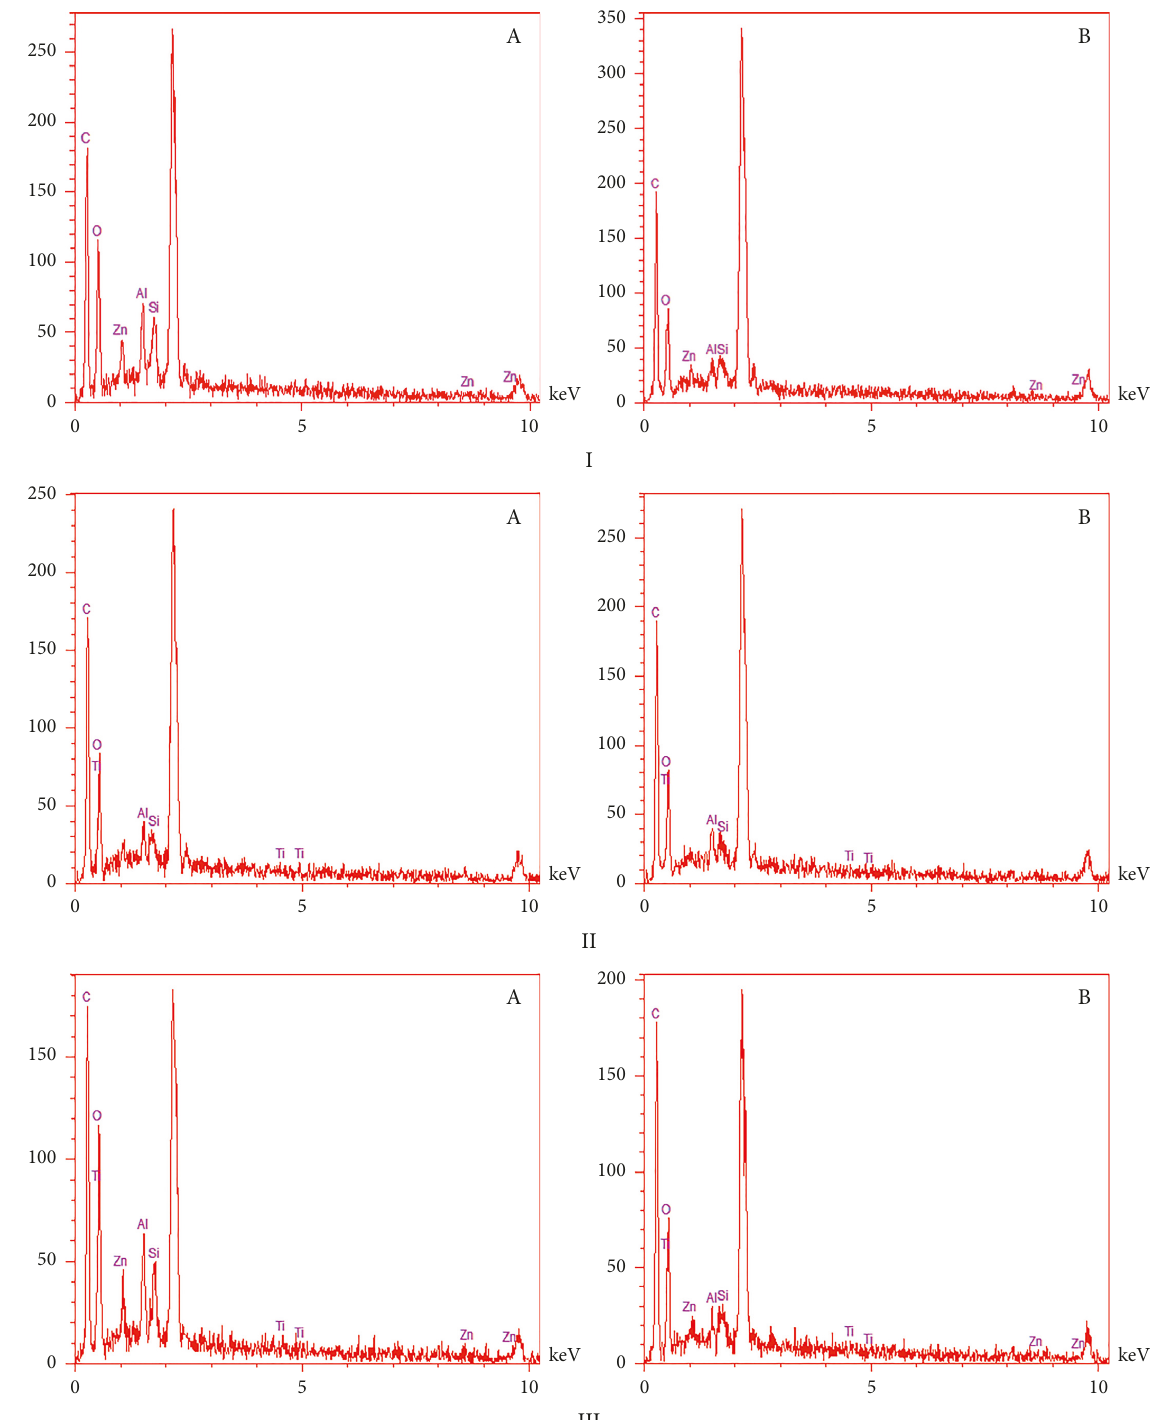
Figure 3: EDX analysis of polymerized acrylic resin containing I (ZnO/4A, II) (TiO for 2wt% of each